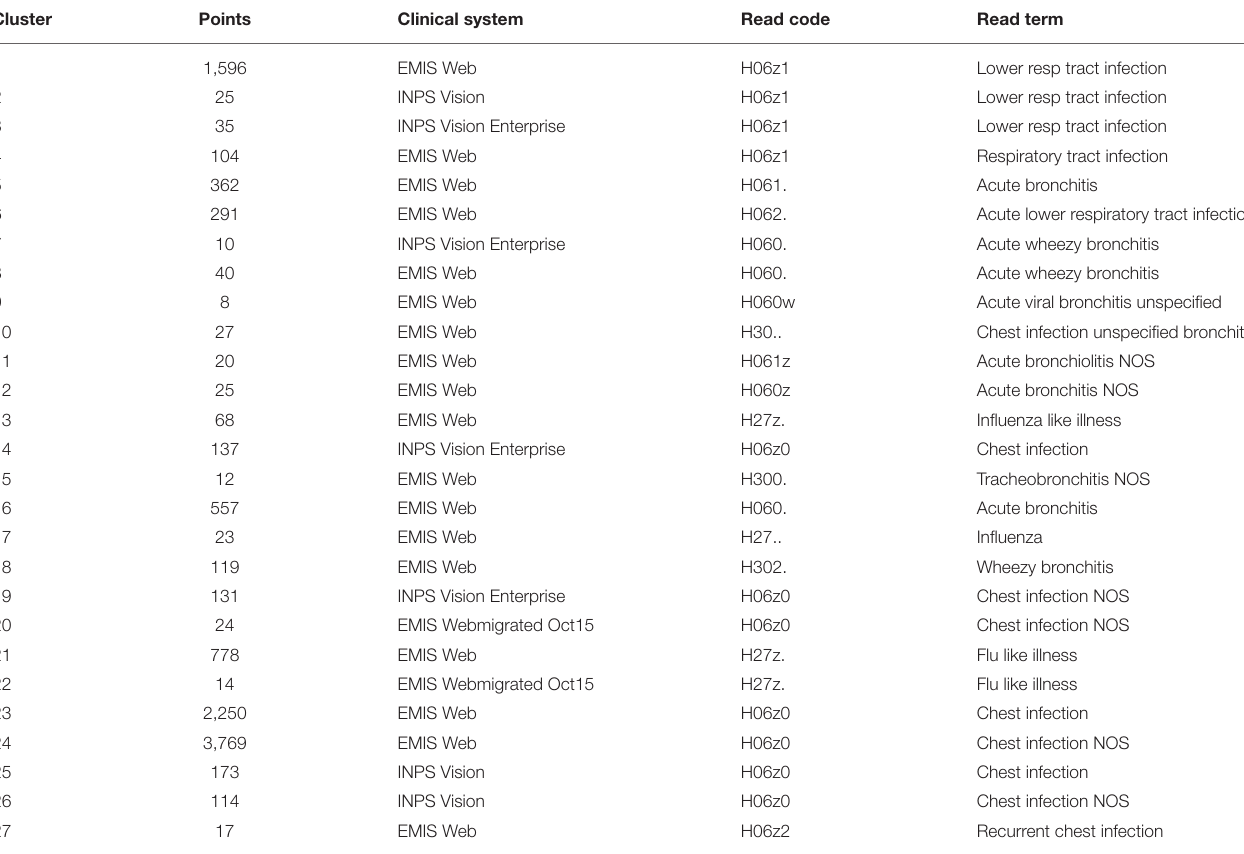
TABLE 1 | Key attributes in driving formation of clusters covering 97.84% of the data. Cluster Points Clinical system Read code Read